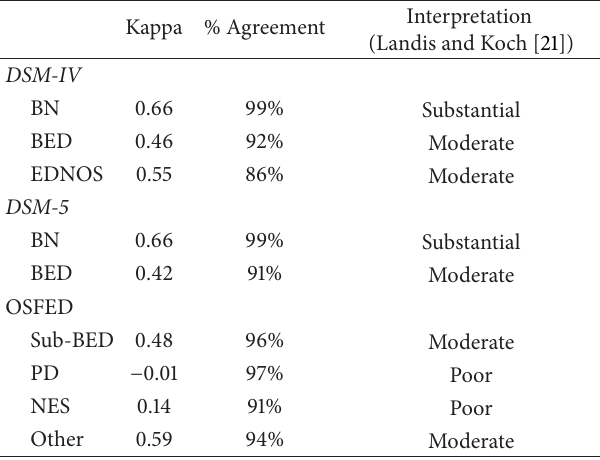
Table 6: Interrater reliability between structured interview and routine clinical interview for DSM-IV and DSM-5 eating disorder diagnoses in an outpatient weight-loss seeking